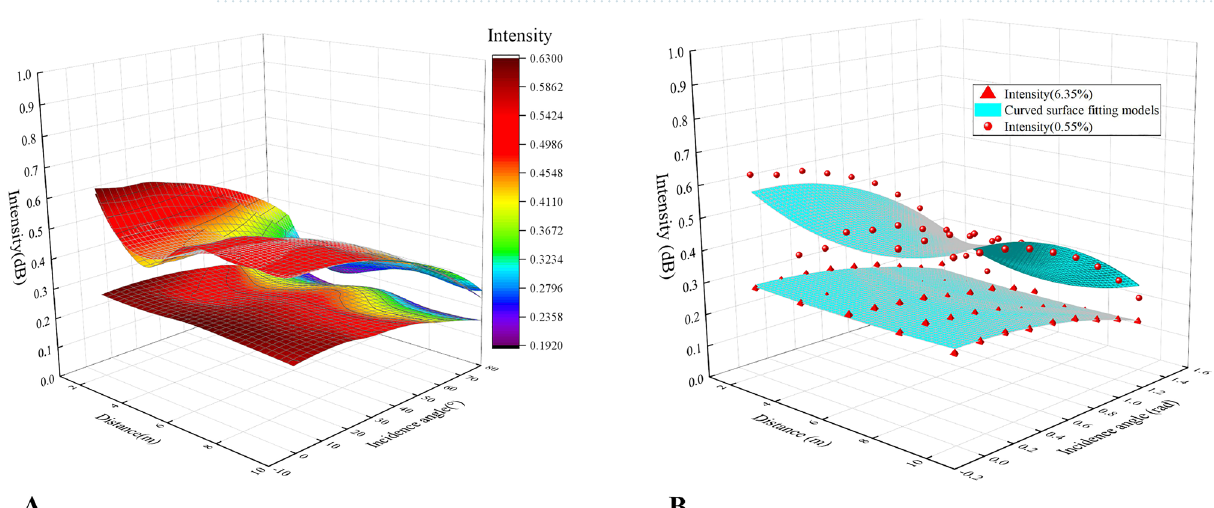
Figure 6. Composite relationships ( A ) and fitting functions ( B ) among the laser reflection intensity and incidence angle as well as distance at the moisture contents of 0.55% and 6.35% (Software: Riscan pro 2.1; riscan-pro.software.informer.com; Origin 2021b; https:// www. origi nlab. com/ index. aspx? go= PRODU CTS/ Origin).